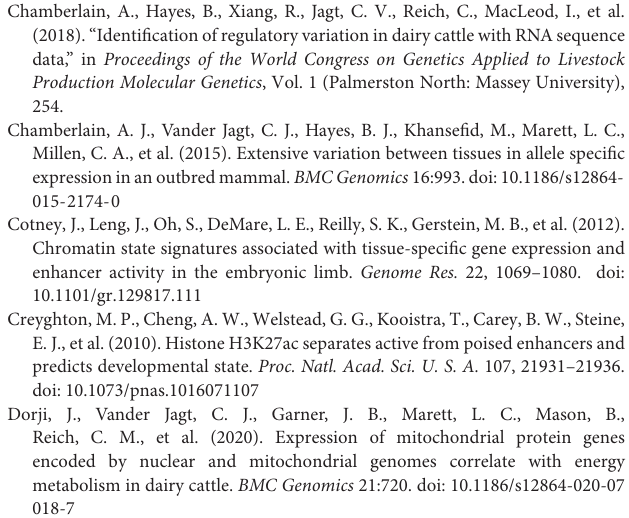
Supplementary Table 1 | Summary of 86 ChIP-seq datasets. The number of biological replicates is shown for each tissue-mark combination. Supplementary Table 2 | Summary data for each ChIP-seq library. Information on the number of mapped reads, quality and coverage of the genome for each ChIP-seq dataset. Supplementary Table 3 | Correlation between ChIP-seq and RNA-seq counts. The number of tests for correlation between gene expression and peak height as well as the number and percentage significantly correlated ( P < 0.05) for each mark. All peaks within 100 kb of a gene were tested. Supplementary Table 4 | Active and inactive genes used for ChromHMM annotation. The number of genes defined as active, tissue-specific active and